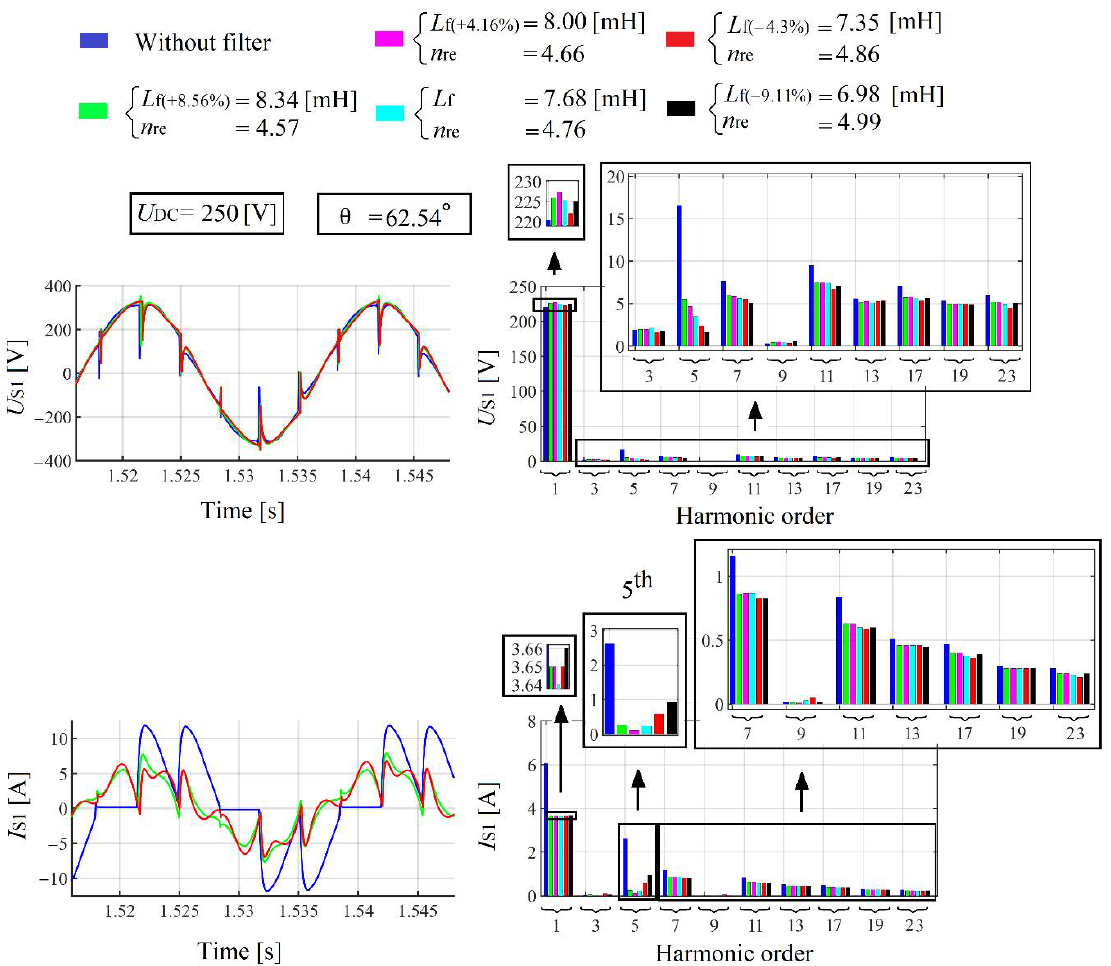
Figure 54. Point of common coupling voltage and current waveforms and spectrums.